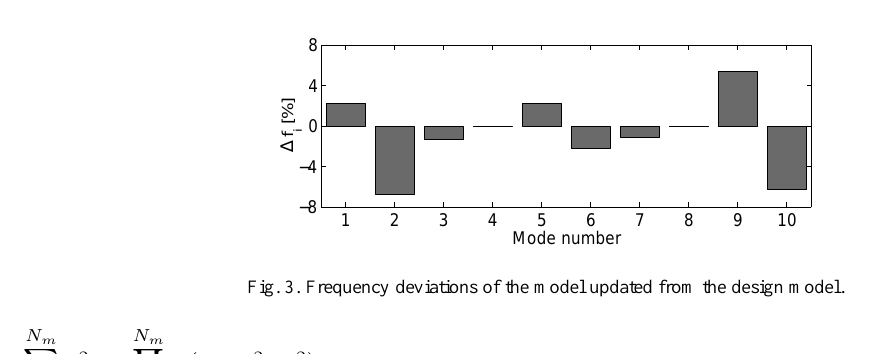
Fig. 2. Frequency deviations of the design model.